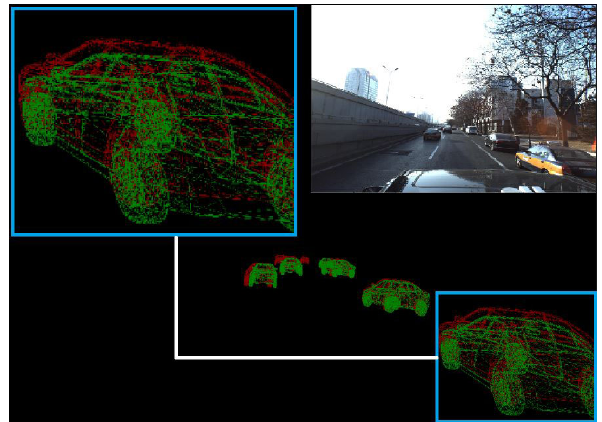
Figure 8. Evaluation metric computes the translation and rotation error between green predictions and red ground truth.